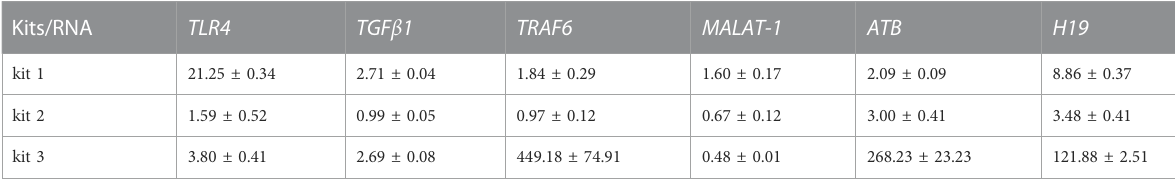
TABLE 4 The relative transcriptional readouts of informative mRNAs and lncRNAs in TNBC in each group.